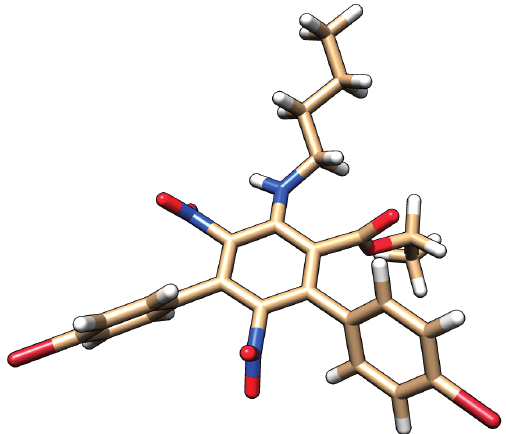
Figure 1. Three-dimensional structure of compound 2 , minimized at the 6-31+G*